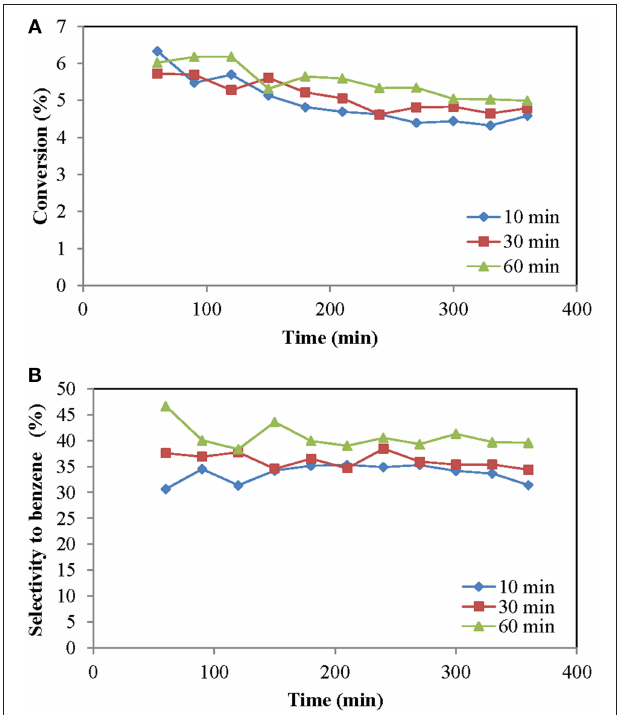
FIGURE 3 | Influence of the carburization period (time on stream): (A) Methane conversion, (B) Selectivity to benzene. Operating conditions: W cat = 18g, CH 4 :O 2 :N 2 = 70:29.25:0.75, u rlowerzone = 2, u rupperzone = 6.7 and T = 700 ◦ C.